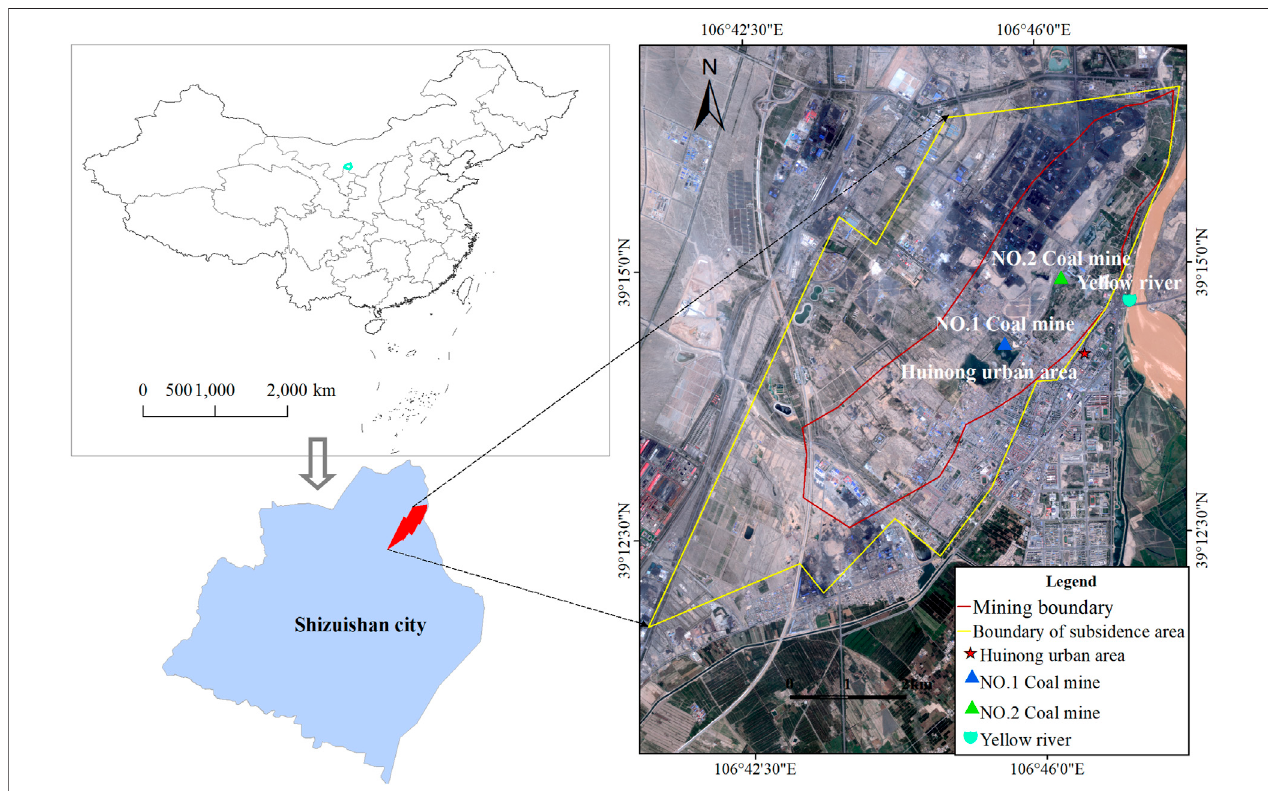
FIGURE 1 | Location of the study